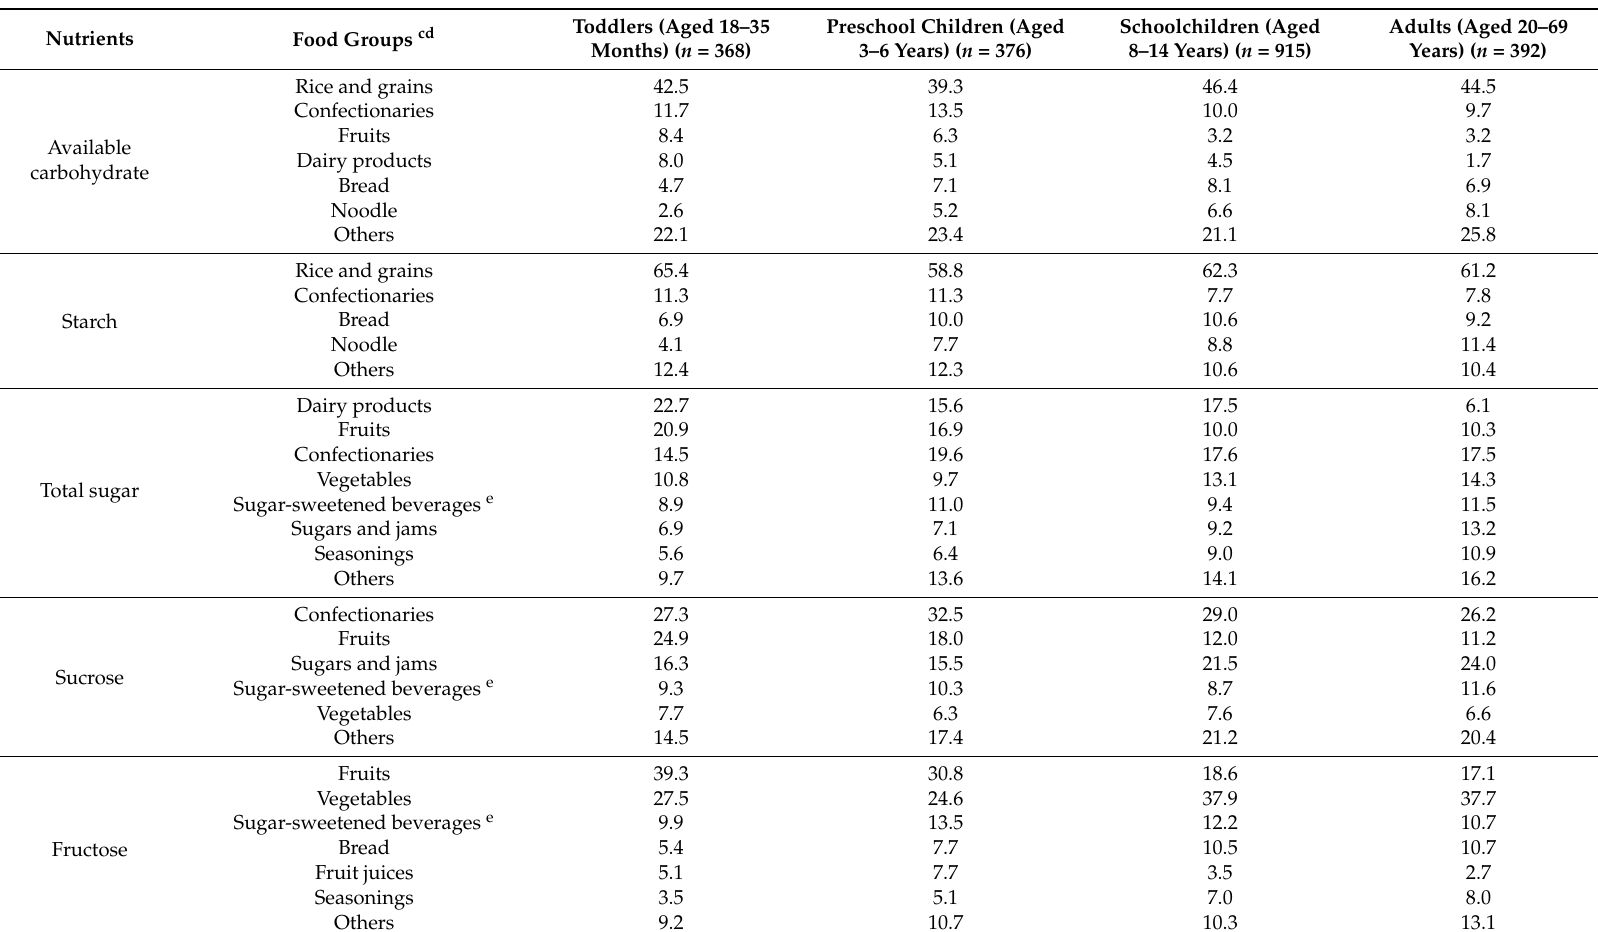
Table 3. Contribution (%) of each food group to intakes of available carbohydrate, starch, total sugar, sucrose, fructose, naturally occurring sugar and free sugar in Japanese children and adults